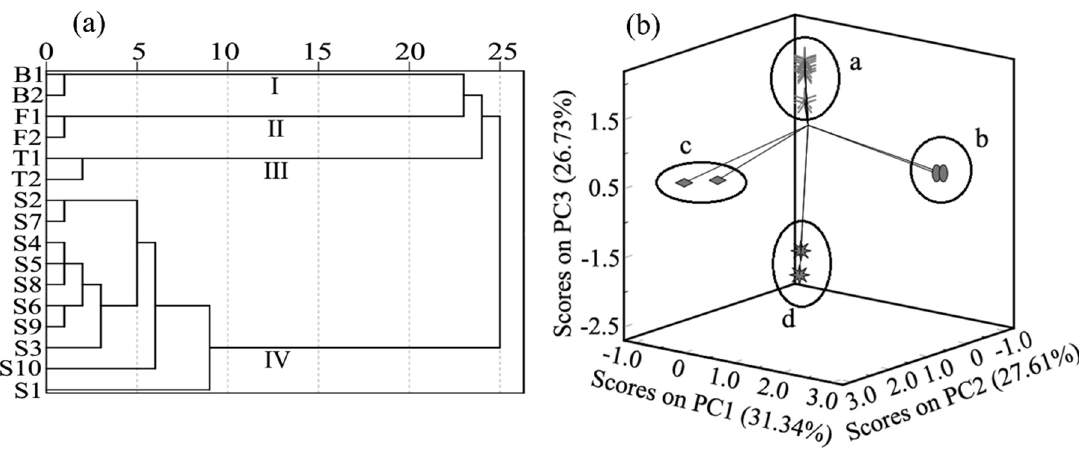
Figure 5. ( a ) The results of hierarchical cluster analysis of 10 batches of Ranae Oveductus and six counterfeit samples, ( b ) principal component analysis (PCA) score chart of 10 batches of Ranae Oveductus and six counterfeit samples in the first three principal components (PCs).